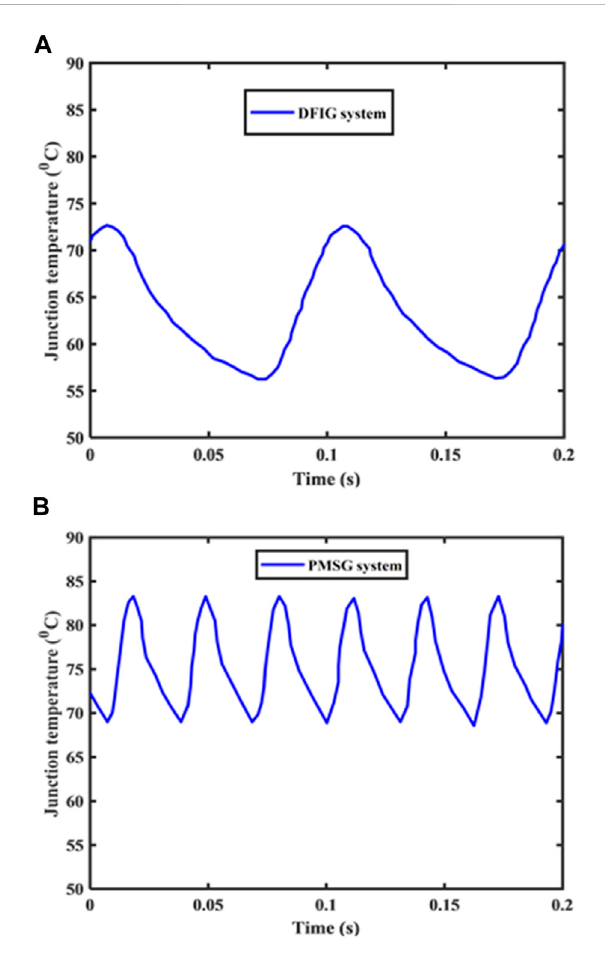
FIGURE 5 Junction temperature of power devices with generator systems of a 2-MW wind power converter: (A) DFIG system ’ s rotor side converter and (B) PMSG system ’ s machine sideconverter (Blaabjerg and Ma, 2017). FIGURE 6